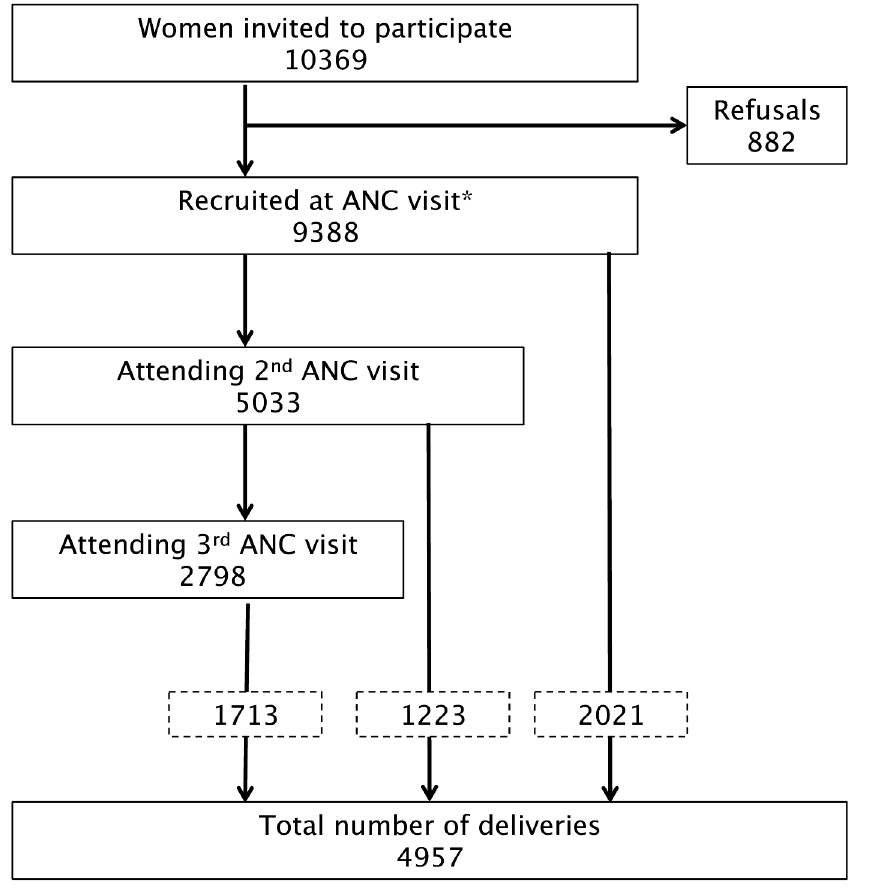
Fig 1. Study profile. * Number recruited at antenatal care per country: 2009 in Guatemala, 2043 in Colombia,1657in Brazil, 1982 in India, and 1697 in PNG.